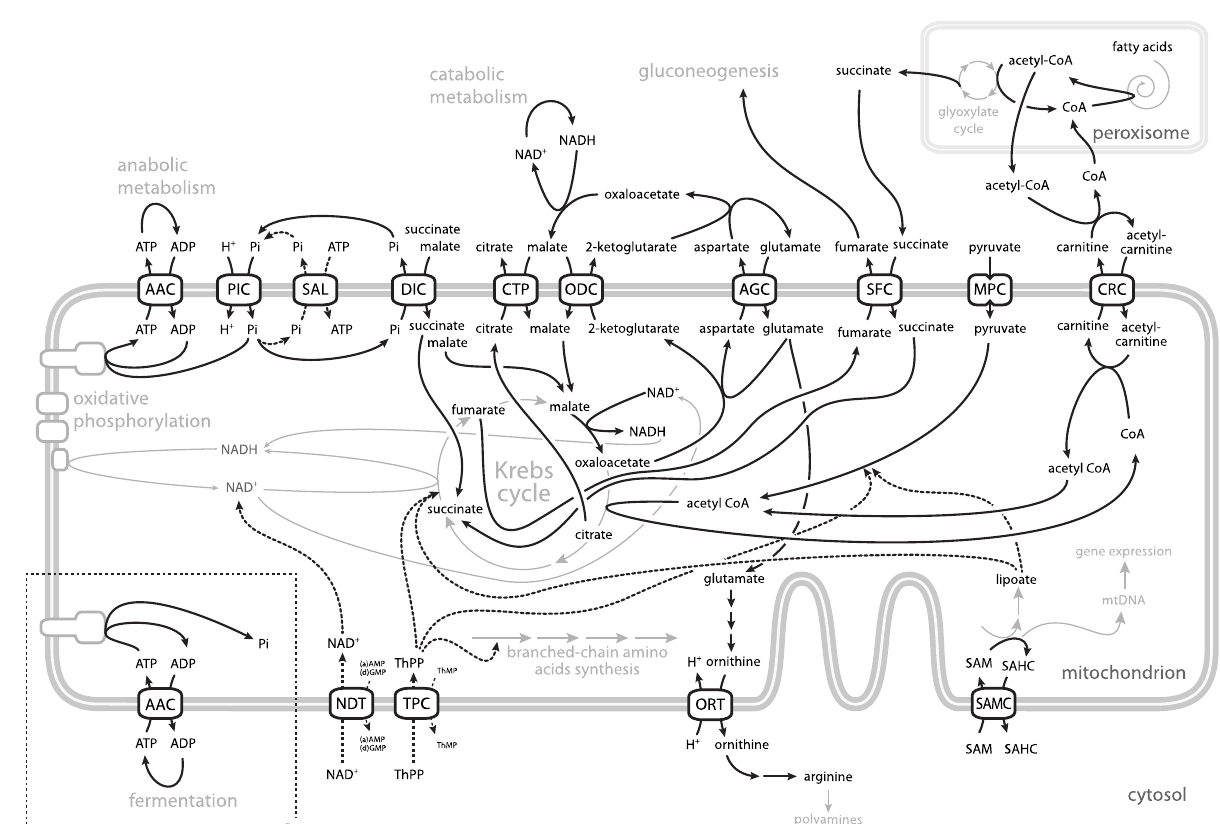
Figure 1. Role of mitochondrial carriers in cell metabolism. Participation of individual mitochondrial carriers in cellular metabolic pathways is indicated. Dashed arrows indicate transport that mediate the maintenance of mitochondrial pool of respective metabolite rather than metabolic flux. In the dotted rectangle, the transport of adenine nucleotides under anaerobic and fermentative conditions is shown. Outer mitochondrial membrane is not shown as it is permeable for all depicted solutes. Abbreviations: AAC—ADP/ATP carrier, AGC—aspartate-glutamate carrier, CTP—citrate carrier,